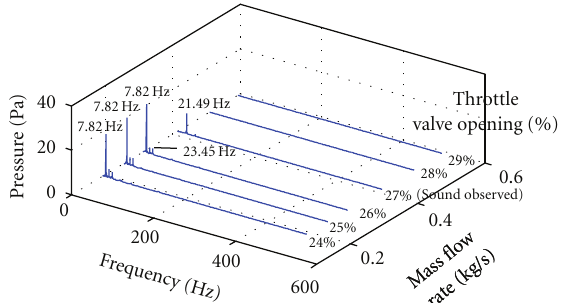
Figure 12: Waterfall plot of the exhaust (discharge plenum) pressure at 10,000 rpm.